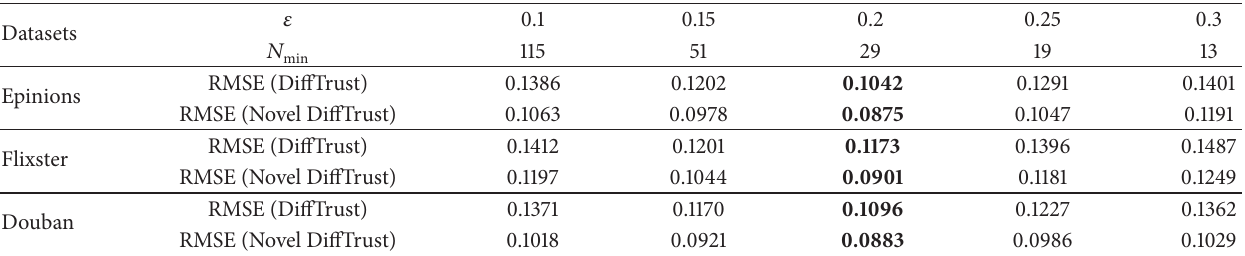
Table 2: Shows the impacts of 𝜀 on RMSE.